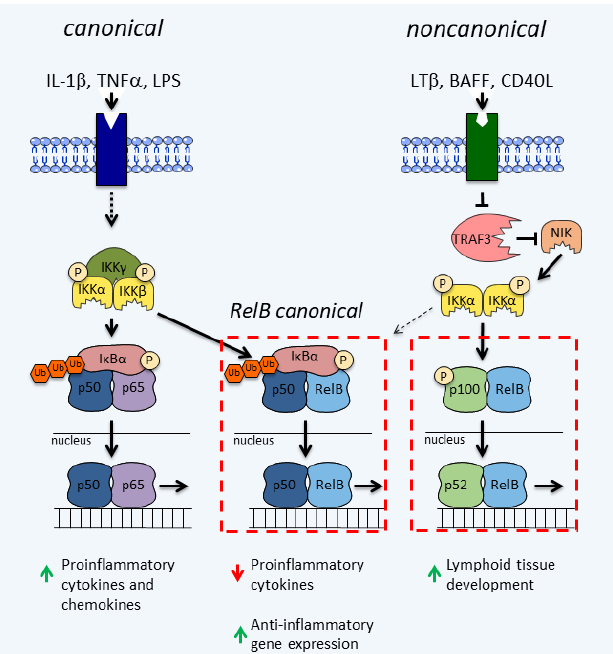
Figure 1. Activation of RelB by the nuclear factor kappa B (NF-κB) signaling pathways. The canonical NF-κB pathway is activated by interleukin 1β (IL-1 β), tumor necrosis factor α (TNFα), and liposaccharide (LPS). The noncanonical NF-κB pathway is activated by lymphotoxin β (LT β ), B cell activating factor of the TNF family (BAFF), and CD40 ligand (CD40L). The canonical activation of RelB/p50 occurs in cells expressing high levels of RelB (basally or after induction). IκB, inhibitor of NF-κB; IKK, IκB kinase; NIK, NF-κB-inducing kinase; P, phosphate; and TRAF3, TNF receptor-associated factor 3.